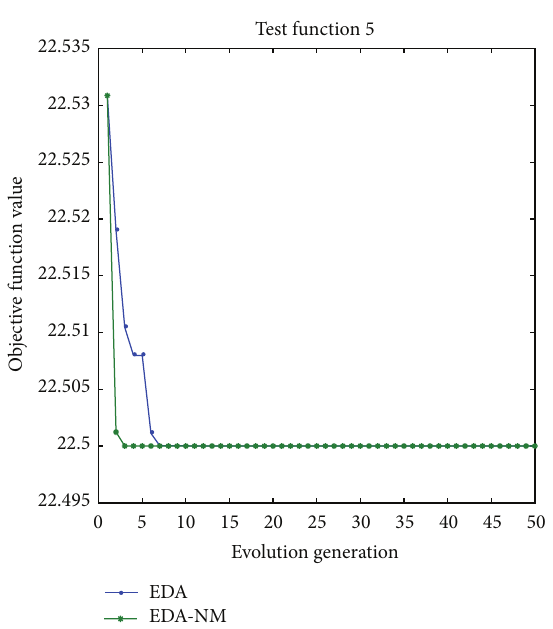
Figure 6: Convergence figure on test problem